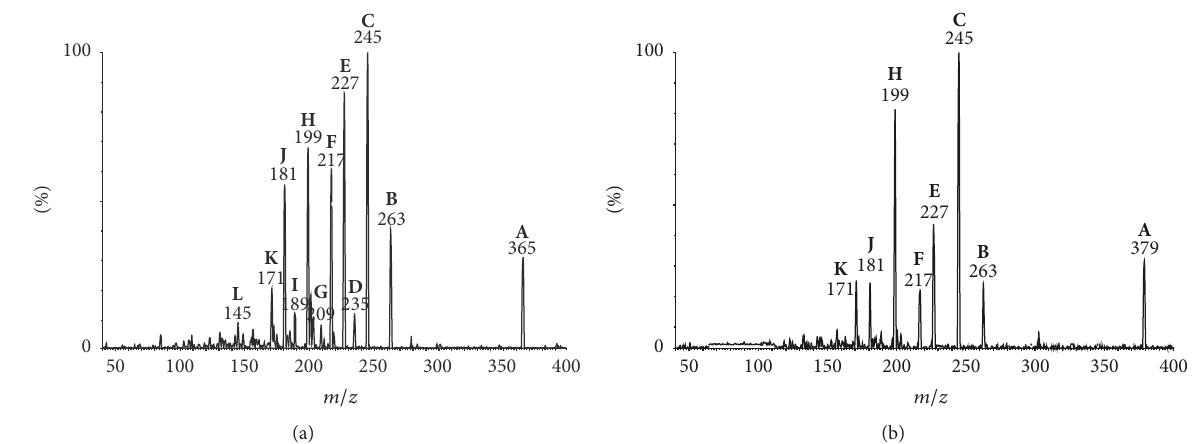
Figure 2: Product ion spectrum of the protonated 1 (a) and 2 (b) ( 𝐸 lab = 15 eV).